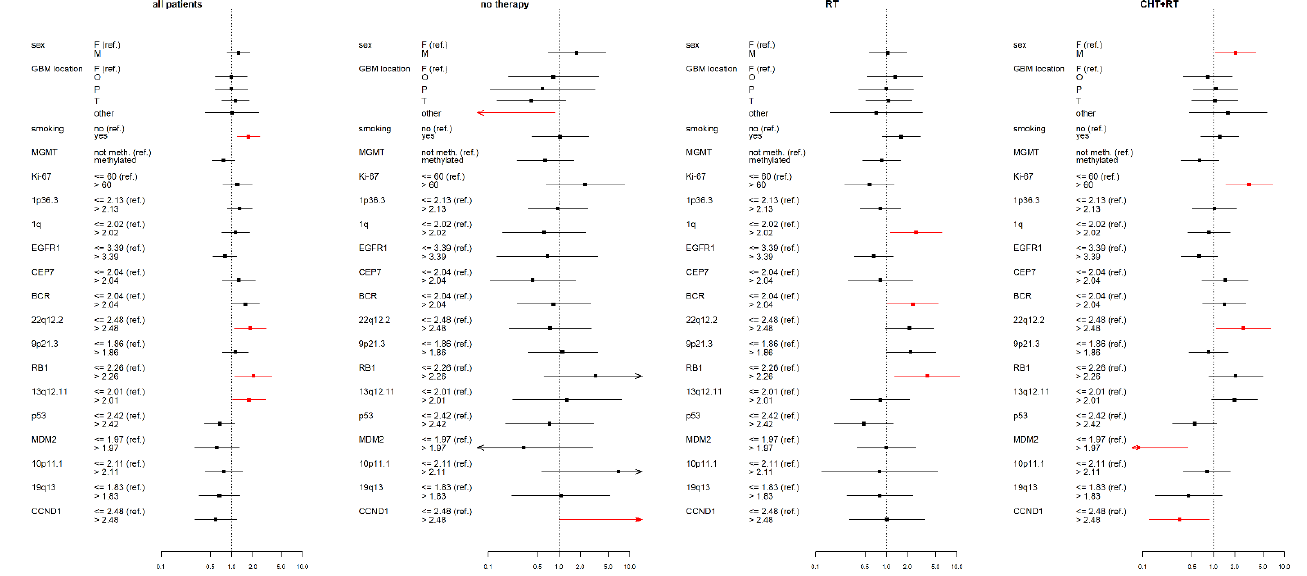
Figure 2. Results of the multivariate Cox proportional hazard models of overall survival (OS) for studied variables (selected clinical factors and molecular markers) in therapy subgroups, expressed using a hazard ratio (a square point—the point estimation, a line segment corresponding to the 95% confidence interval; in case of wider interval than presented scale the arrow is used) for each level of presented factors. The reference category of each factor is labeled with “(ref.)”. Each factor was analyzed in a separate model with adjusting variables—categorized age and Karnofsky score (HRs are not presented). Significant results ( p < 0.05) are shown in red; the dotted line indicates a hazard ratio of 1. RT—radiotherapy; CHT+RT—chemoradiotherapy; F—female; M—male; F—frontal; O—occipital; P—parietal; T—temporal; BCR—breakpoint cluster region; EGFR1—epidermal growth factor receptor 1; RB1—retinoblastoma gene 1; TP53 - tumor protein P53;